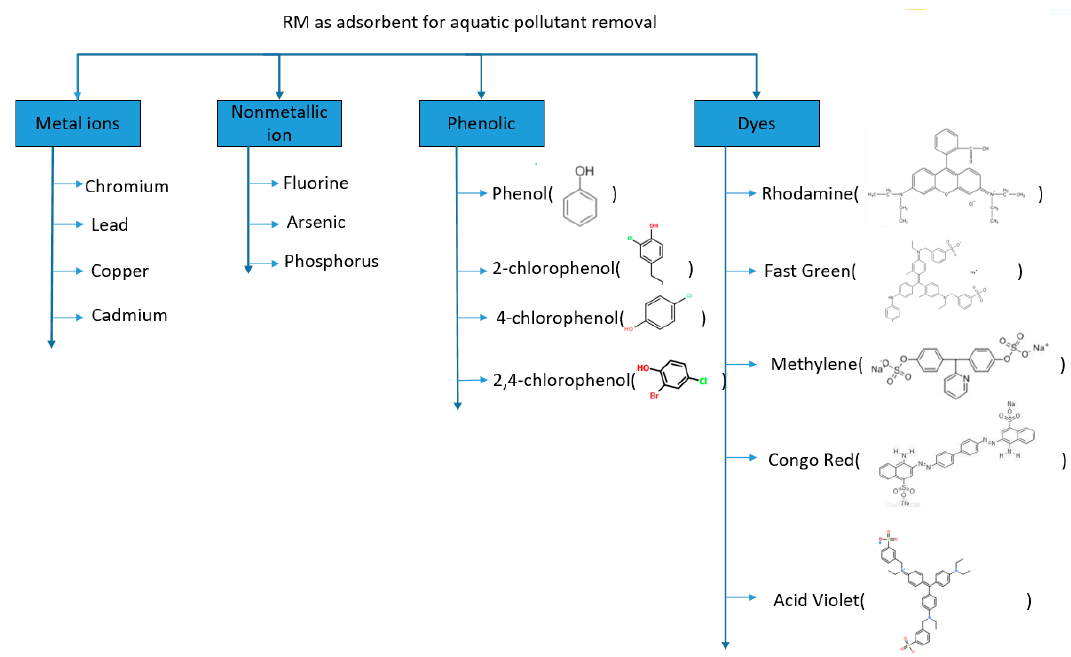
Figure 2. RM as adsorbent for the removal of aquatic pollutants from wastewater. Reproduced with permission from [37], published by Taylor & Francis, 2011.